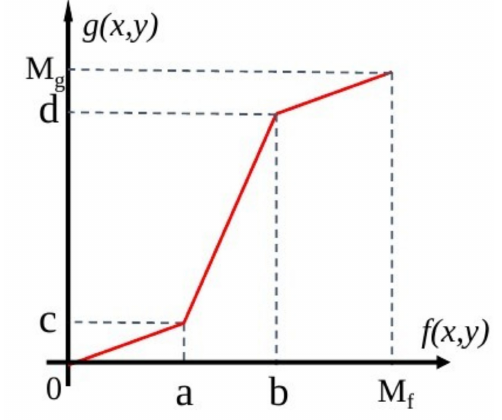
Figure 4. Grey-scale stretching